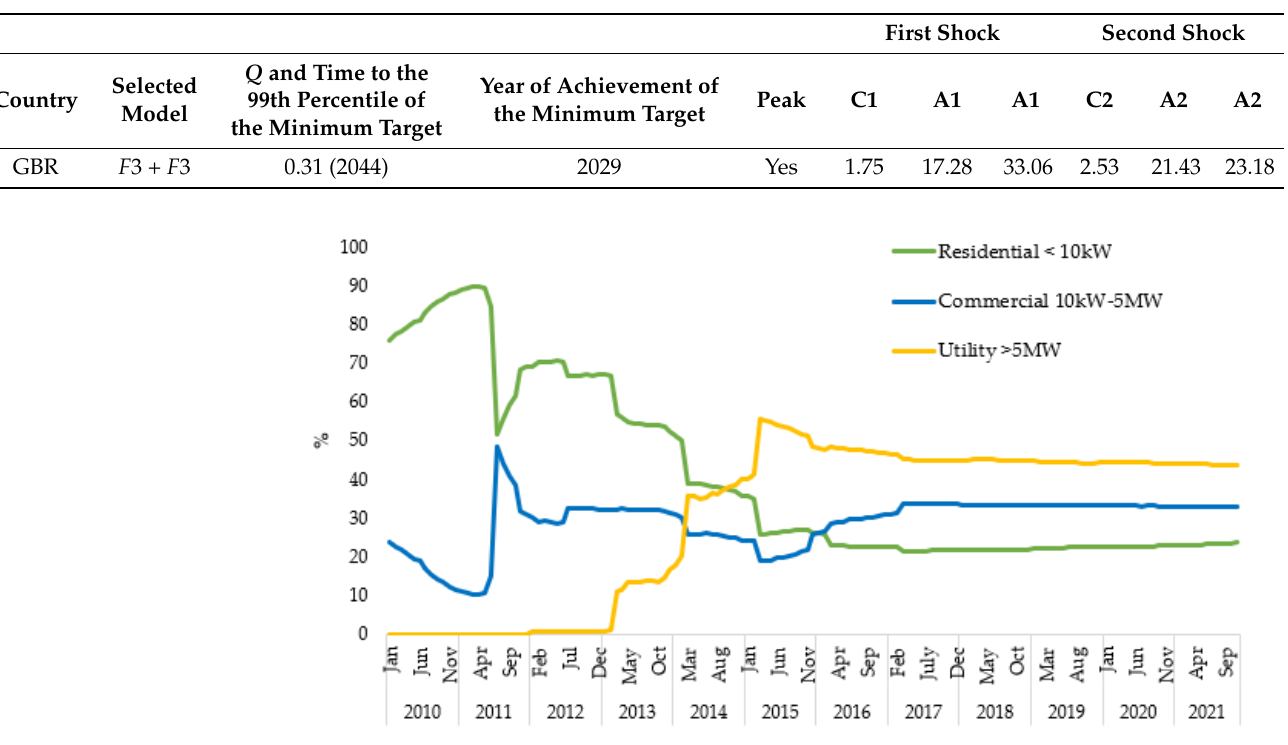
Figure A2. Standard Solar FIT values (high rate) by capacity range in kW from April 2010 to March 2019. Source: Ofgem — UK Government Statistics [44]. NB: FIT payment rates for solar photovoltaic installations determined by the Gas and Electricity Markets Authority (Ofgem) under Article 13 of the Feed-in Tariffs Order 2012. Table A3. The GIM fit in the UK considered under the minimum target: summary information [21].